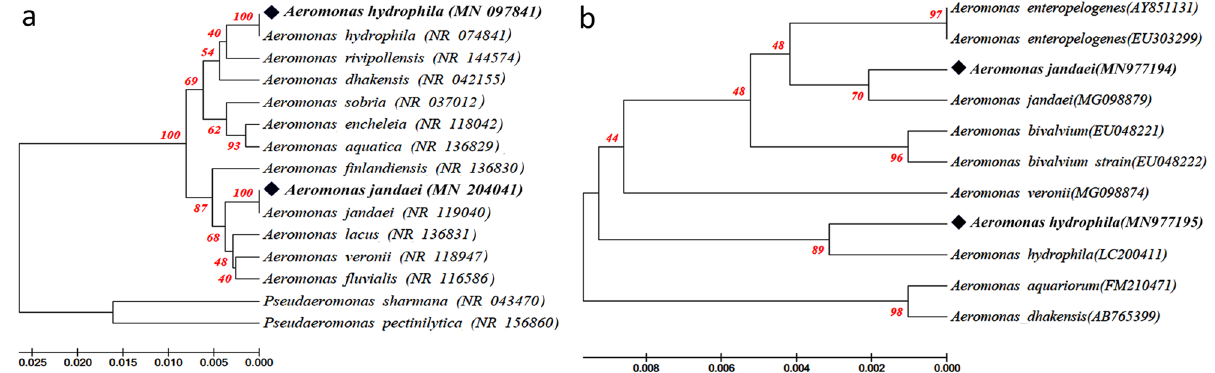
Figure 1. Phylogenetic tree (UPGMA model) based on 16S rDNA ( a ) and rpo B ( b ) of two bacterial isolates (AM-31: Aeromonas hydrophila and AM-05: A. jandaei ) and their closely-related species. Pseudomonas sharmana and P. pectinilytica were selected as outgroups for the 16S gene. Percentage bootstrap values (1000 replicates) are shown at each branch point.